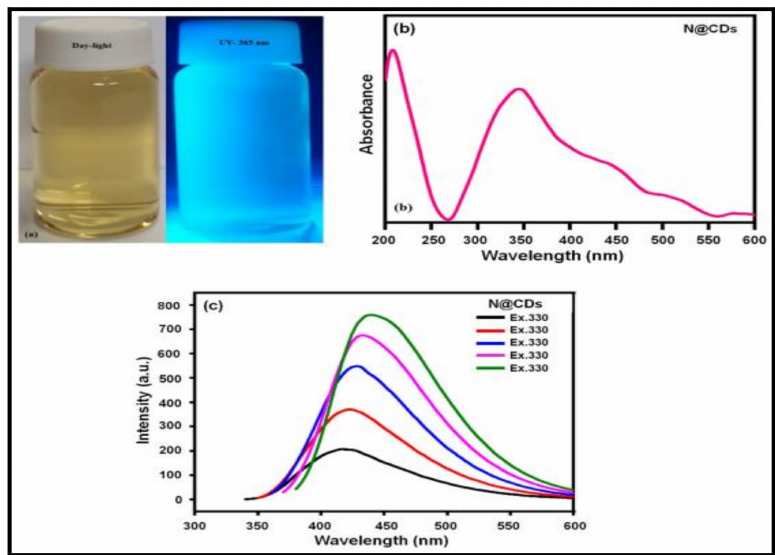
Figure 9. Nitrogen doped carbon dots ( a ) exhibiting fluorescence; ( b ) UV–visible absorbance; and ( c ) fluorescence at various emission wavelengths, reproduced with permission from [65] (Moor- thy et al.,